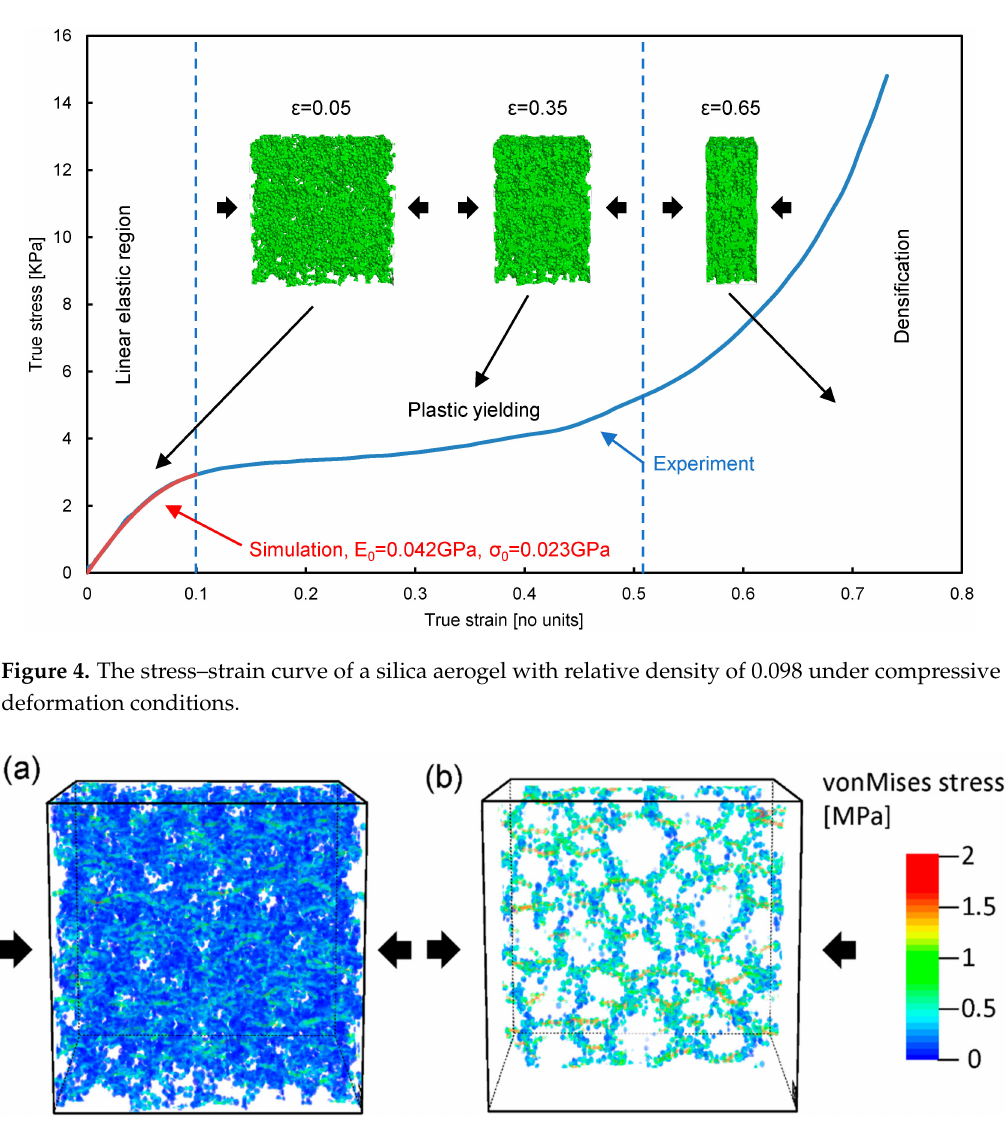
Figure 5. The von Mises stress for the aerogel structure under 0.1 uniaxial compressive deformation. Structural views for the 5 × 5 × 5 ( a ) and its translucent perspectives ( b ) under 0.1 compressive deformation along z -axis. The color map indicates the von Mises